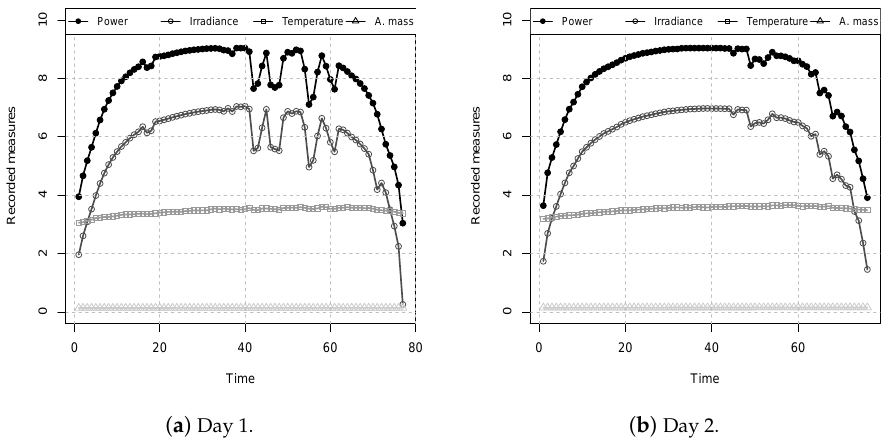
Figure 4. The generated power (kW), temperature (Celsius) and irradiance (kW/m 2 ) measurements in the log scale and the values of the accumulated mass of particles ( µ g/cm 3